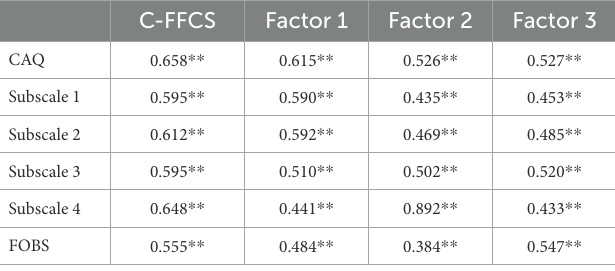
TABLE 7 Correlations of the C-FFCS, CAQ, and FOBS ( N = 381).